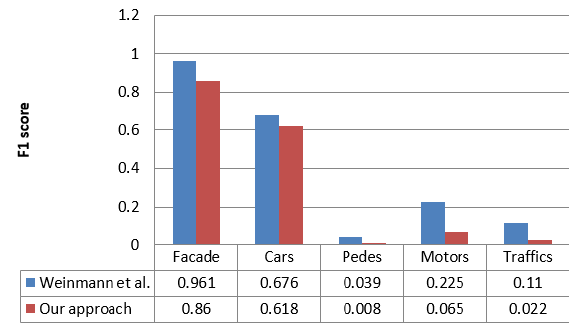
Figure 6. F1-score values in the five classes